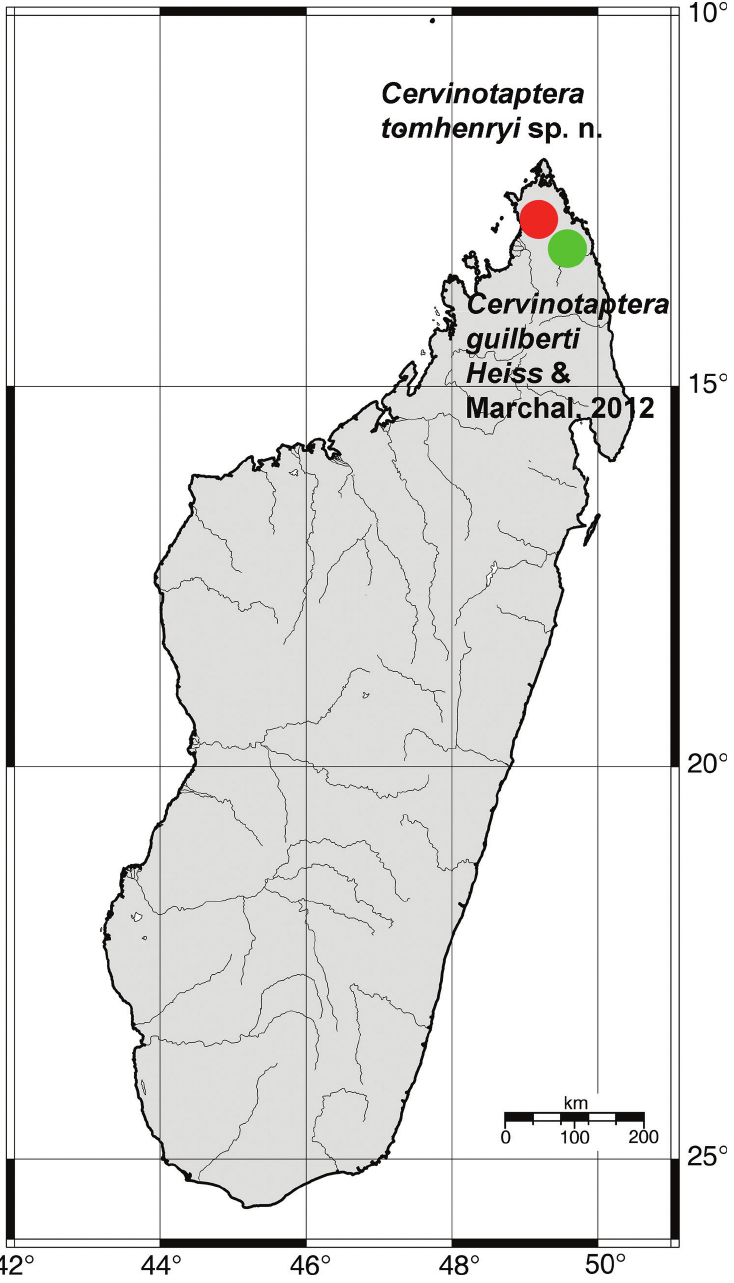
Figure 5. Map of distributions of Cervinotaptera